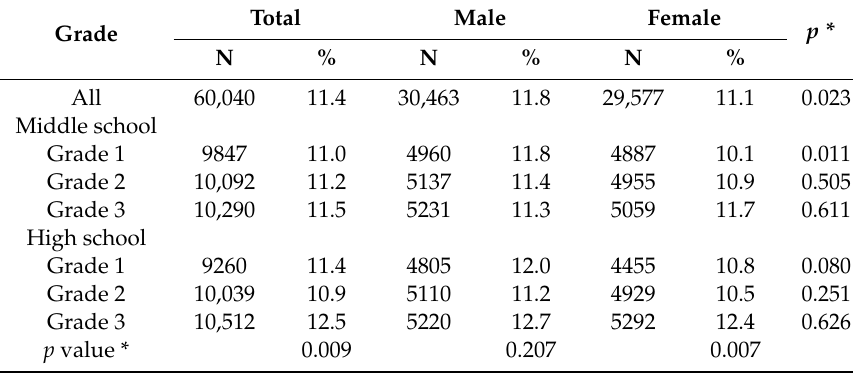
Table 3. Adolescents with tooth fracture experience in the past 12 months.